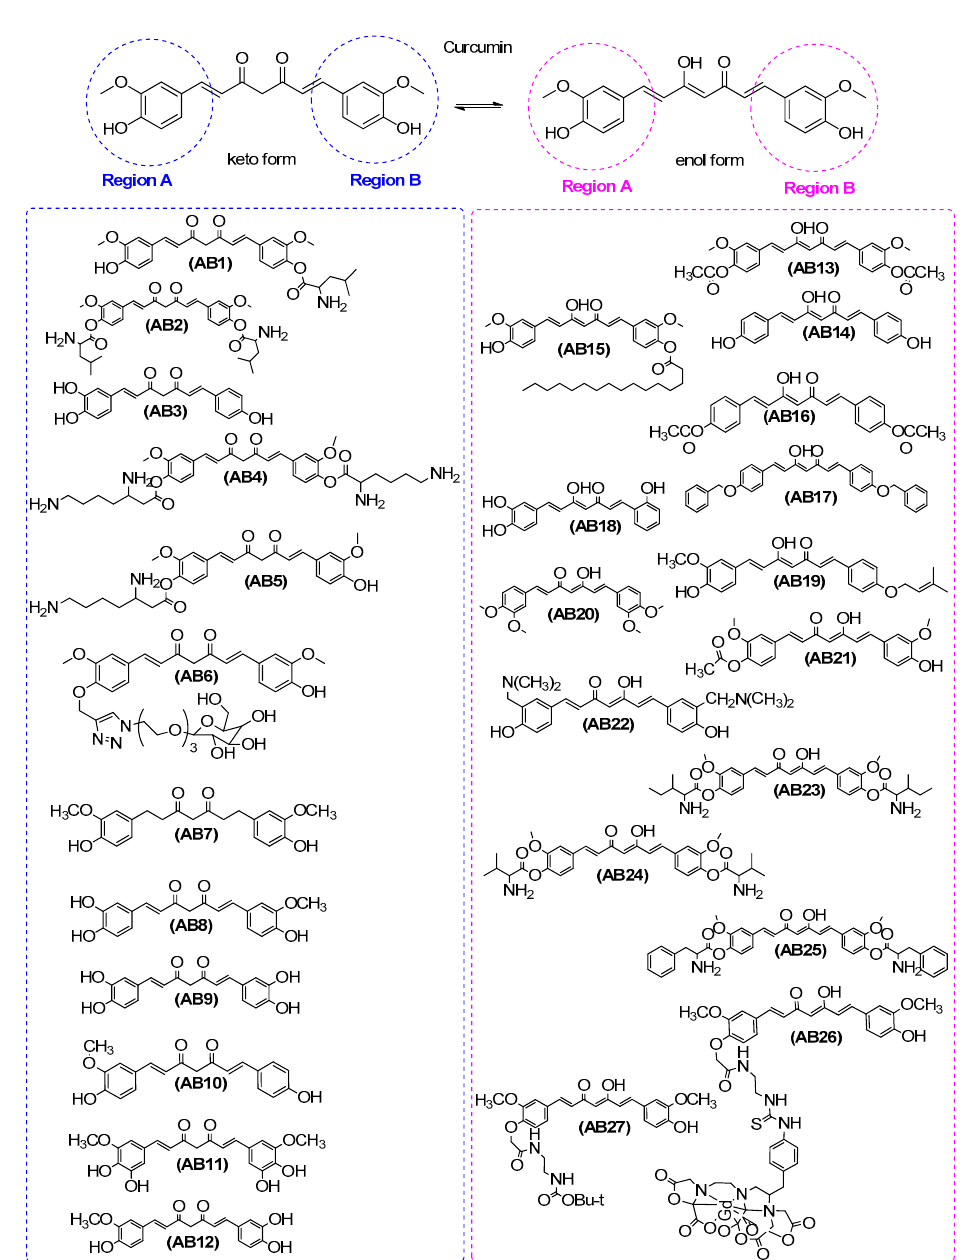
Figure 1. of amyloid- β aggregation. Figure 1. Inhibitors of amyloid- β